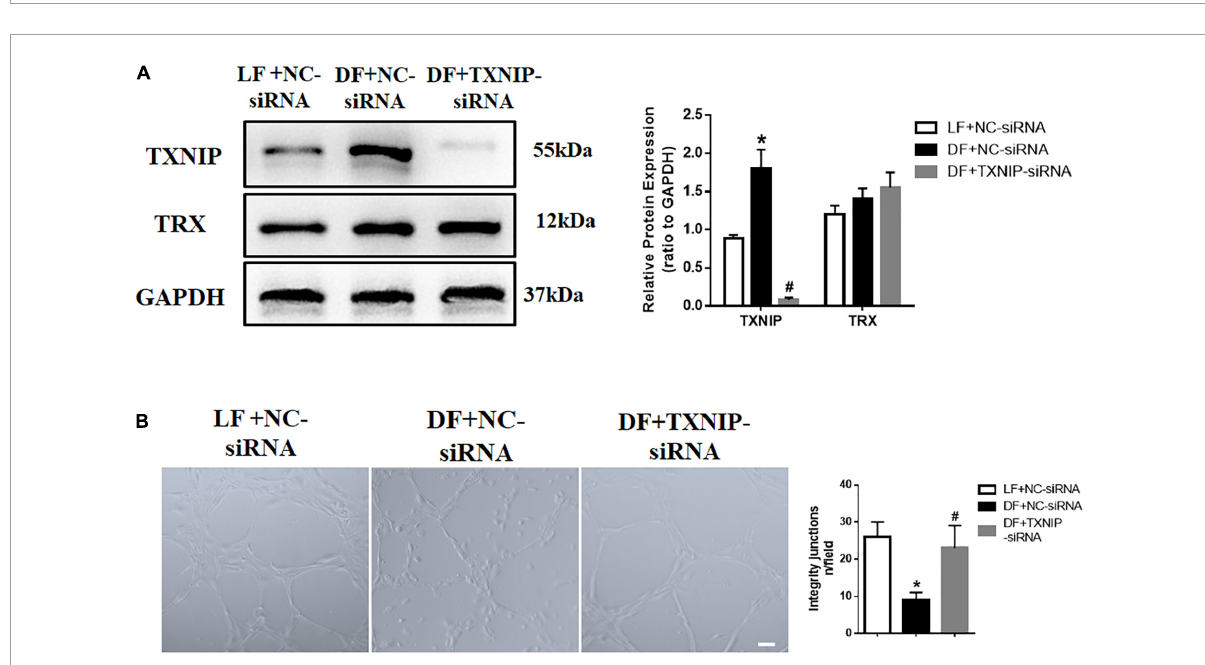
FIGURE2 Increased expression of TXNIP in disturbed flow-induced endothelial dysfunction. (A) Thioredoxin-interactive protein (TXNIP) expression was determined by Western Blotting in the treatment groups of laminar flow with negative control siRNA (LF + NC-siRNA), disturbed flow with negative control siRNA (DF + NC-siRNA) and disturbed flow with TXNIP-siRNA (DF + TXNIP-siRNA). (B) Formation of capillaries in Matrigel. Scale bars = 50 µ m. Results are shown as mean ± SD. N = 5/group. * P < 0.05 vs. LF + NC-siRNA, # P < 0.05 vs. DF +